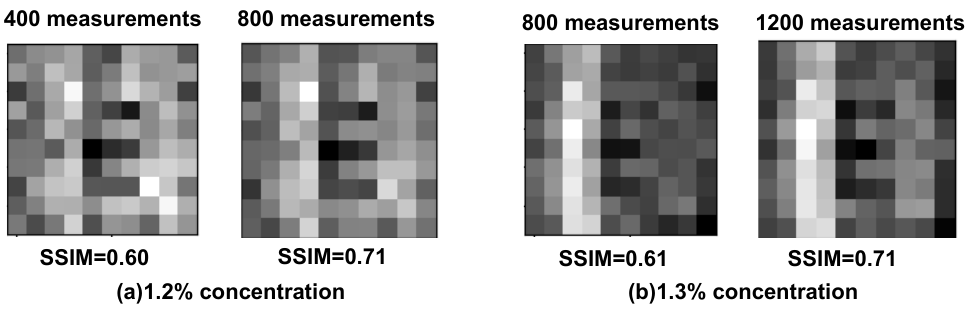
Figure 7. The reconstructed image by the DPGI method with an SSIM value of 0.7 as the boundary: ( a ) 1.2% concentration, left: 400 measurements, right: 800 measurements; ( b ) 1.3% concentration, left: 800 measurements, right: 1200